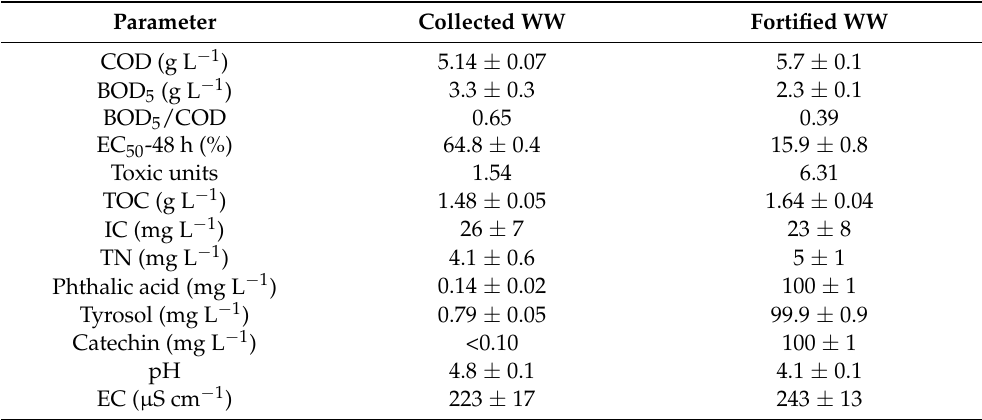
Table 1. Characterization of studied winery wastewater before and after being fortified with recalci- trant